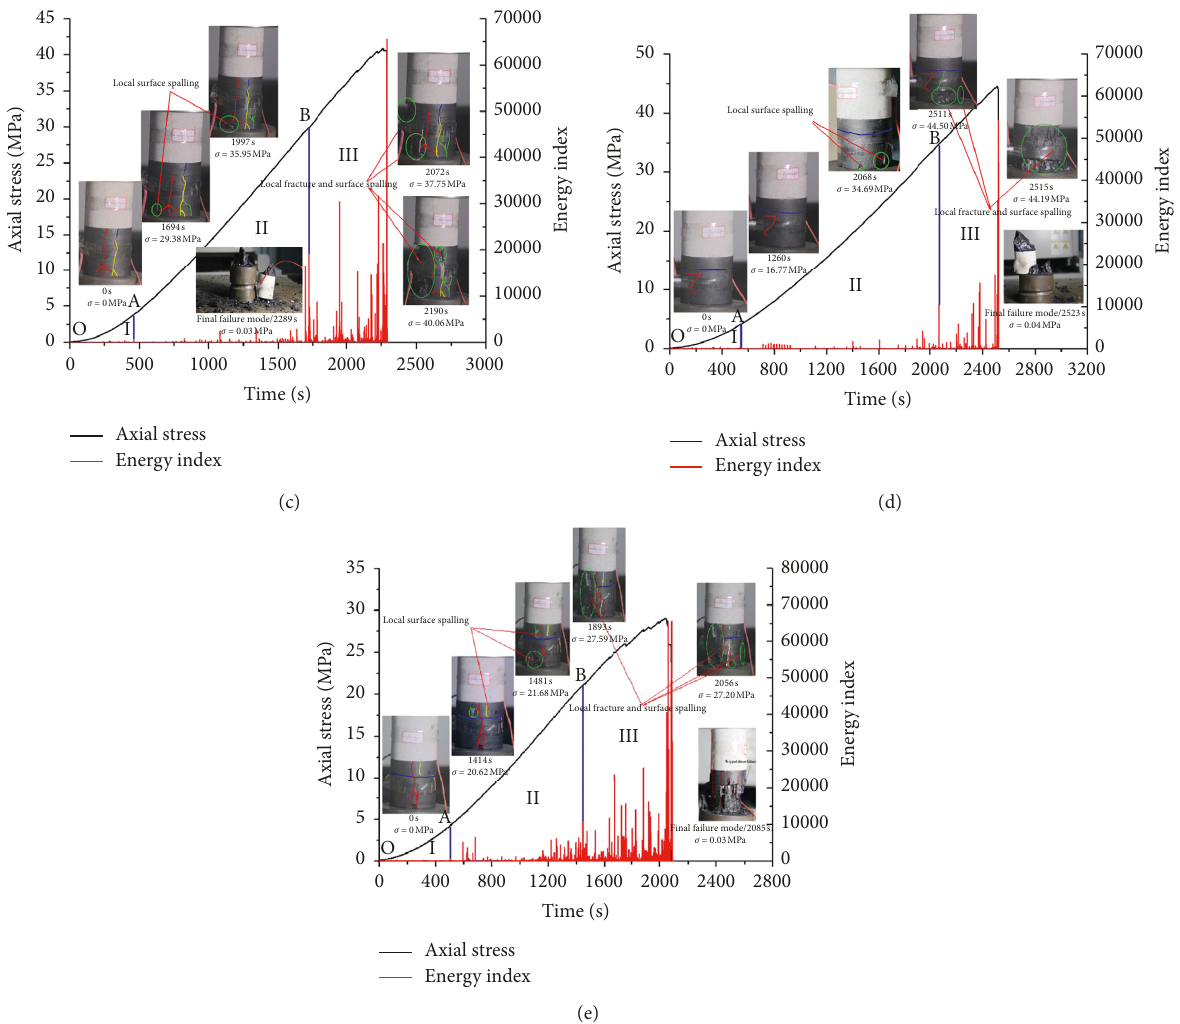
Figure 8: Deformation and failure processes of composite samples. (a) A-1. (b) A-2. (c) A-3. (d) A-4. (e)